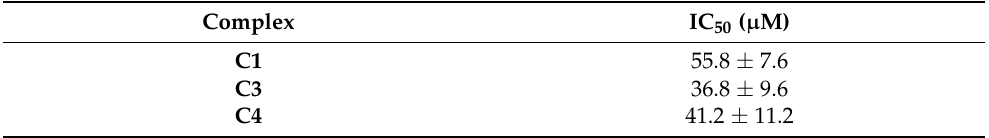
Table 8. IC 50 values, expressed as means ± SD, n =